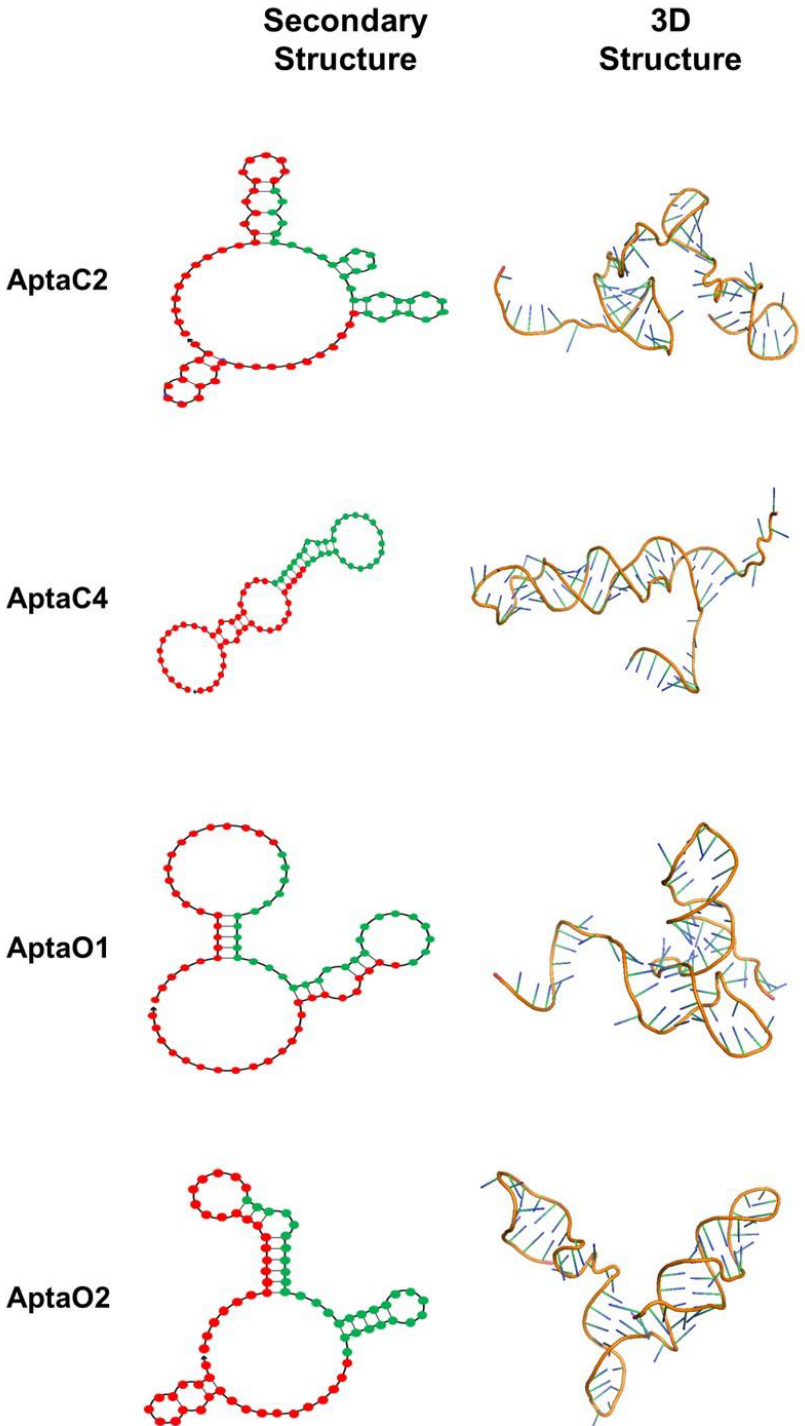
Figure 4. Characterization of secondary and tertiary aptamer structures. The aptamers from Caov-3 (AptaC2 and AptaC4) and from OvCar-3 (AptaO1 and AptaO2), presenting the lower ∆ G, were described. In the secondary structures, the nucleotides marked in red correspond to the adapter sequences, while the nucleotides marked in green correspond to the central core N30.